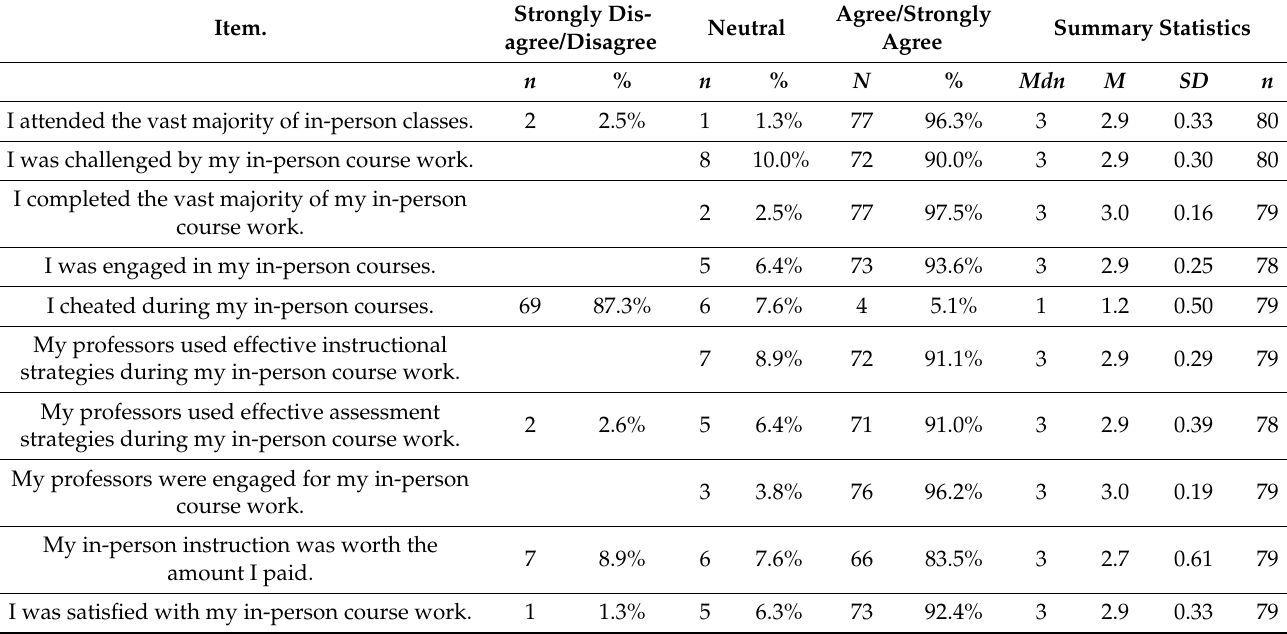
Table 2. General Perceptions of Learning: In-Person.